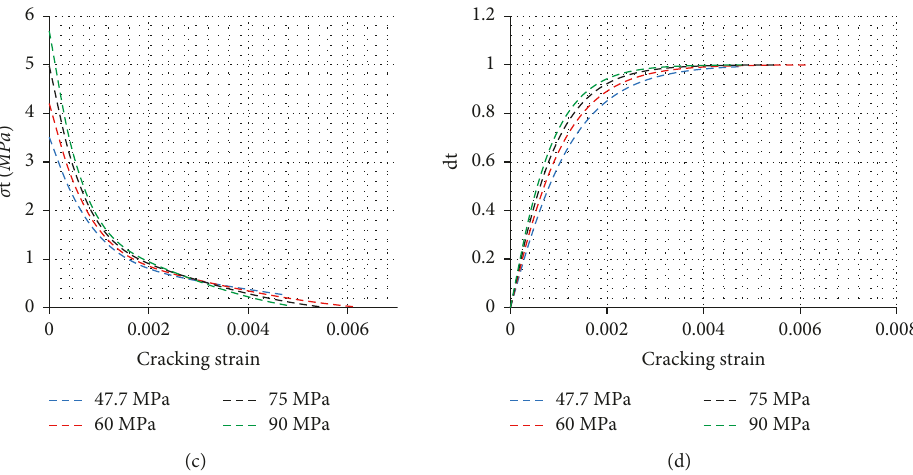
Figure 3: Concrete damaged plasticity model input data for all concrete grades with 30mm element size. (a) Compressive stress vs crushing